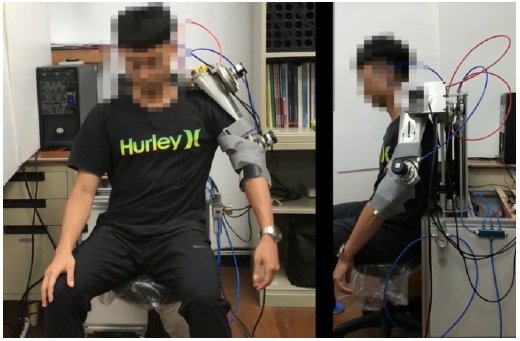
Actuators 2020 , 9 , x FOR PEER REVIEW Figure 16. The realization for shoulder internal/external rehabilitation rotation. Figure 16. The realization for shoulder internal/external rehabilitation rotation. Figure 16. The realization for shoulder internal / external rehabilitation rotation.